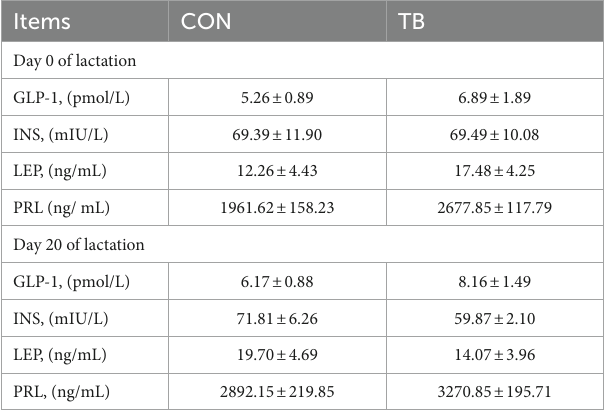
TABLE 5 Effects of tributyrin on blood biochemical indexes of sows.